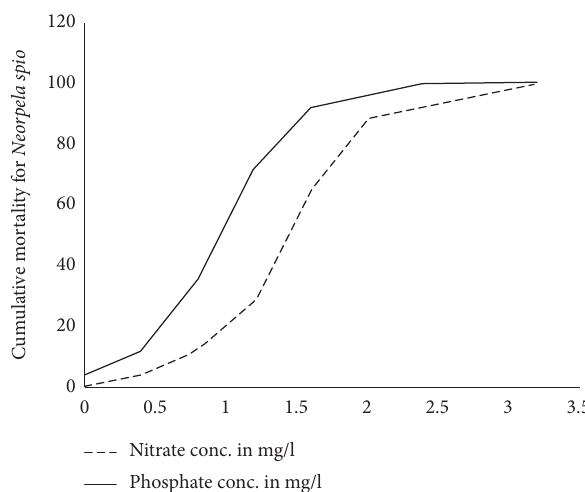
Figure 1: 96-hour concentration response curves showing cu- mulative mortality for N. spio .